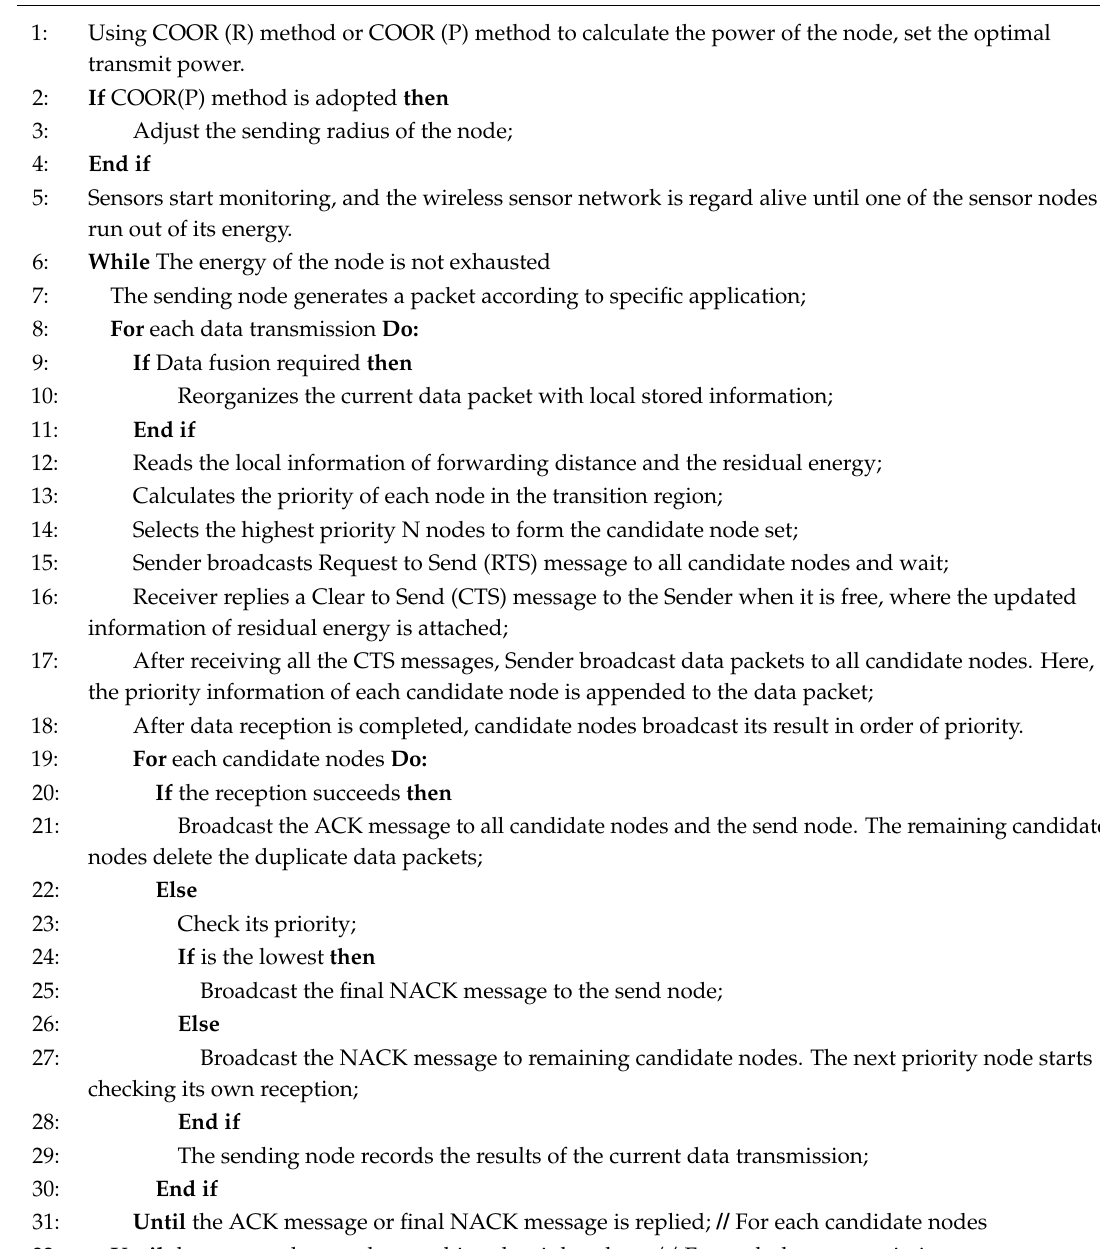
Algorithm 1: COOR scheme for network